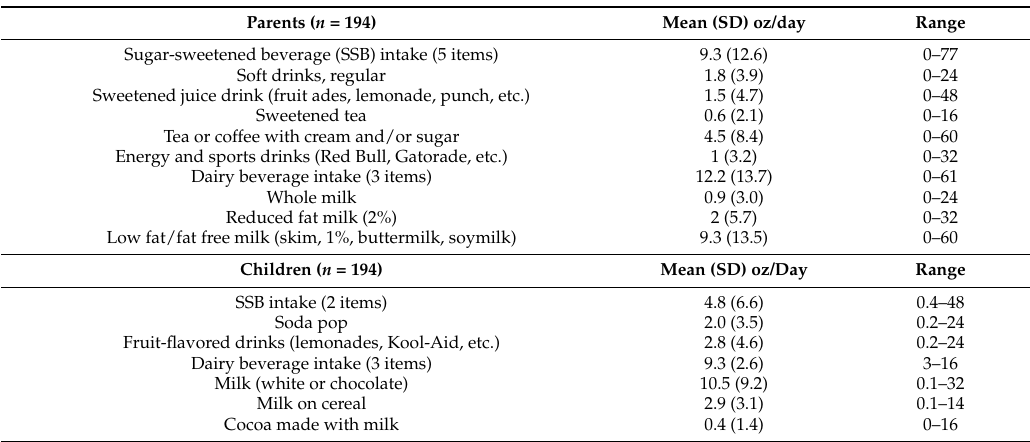
Table 3. Self-reported beverage intake of parents and children in a cross-sectional survey based on frequency and amount